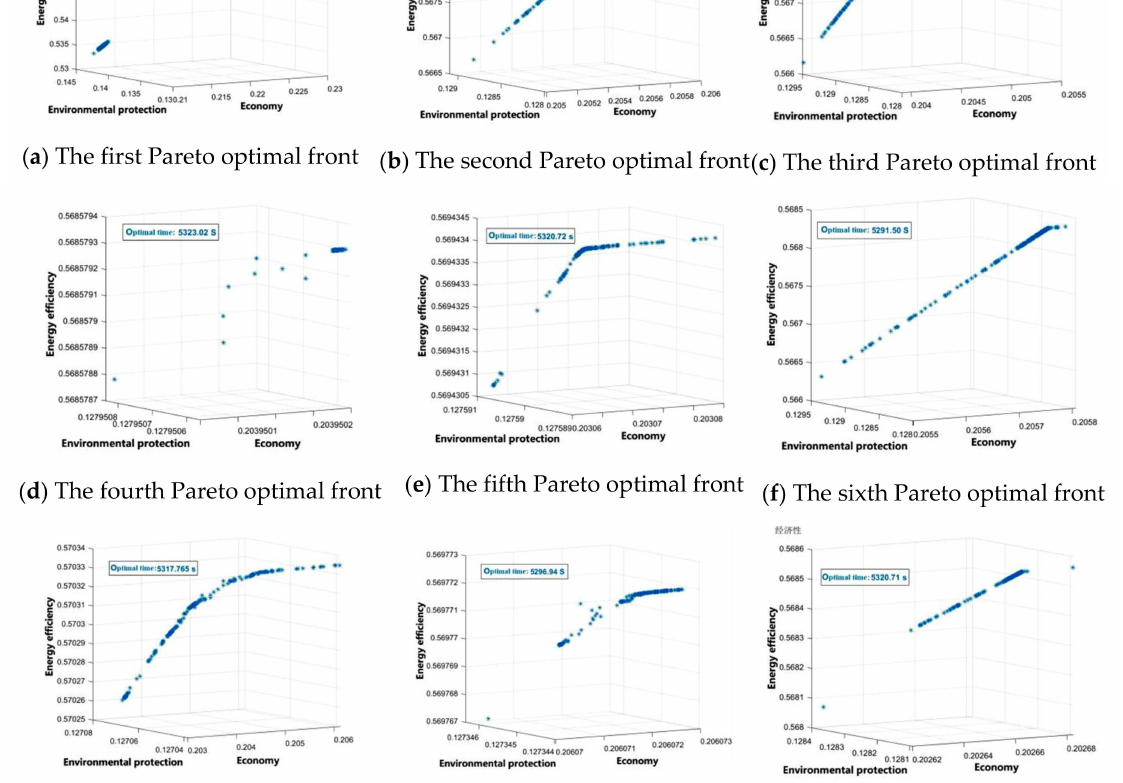
Figure 16. Pareto fronts optimized by the NSGA-III algorithm.